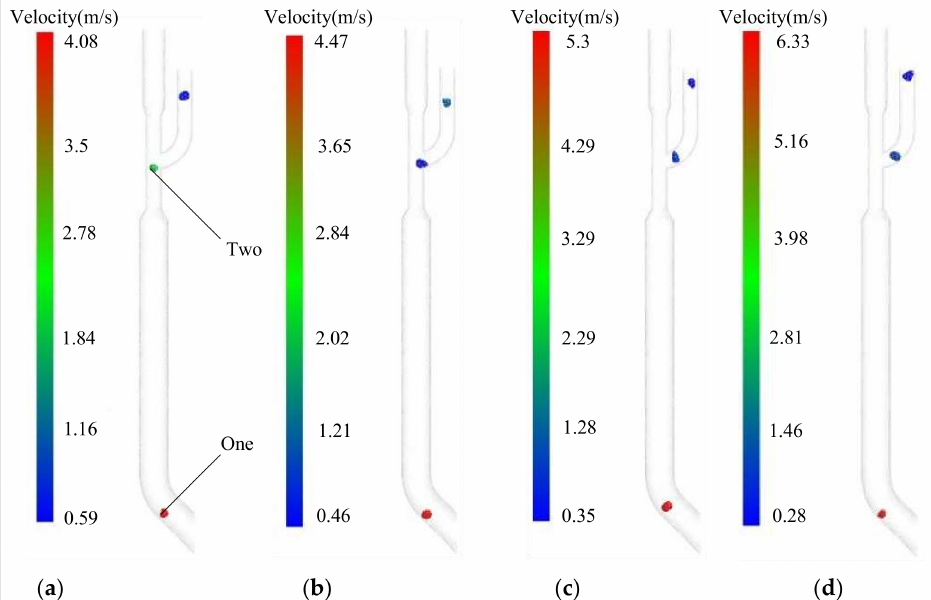
Figure 15. Particle motion process in the delivery device under different inlet-airflow velocities.